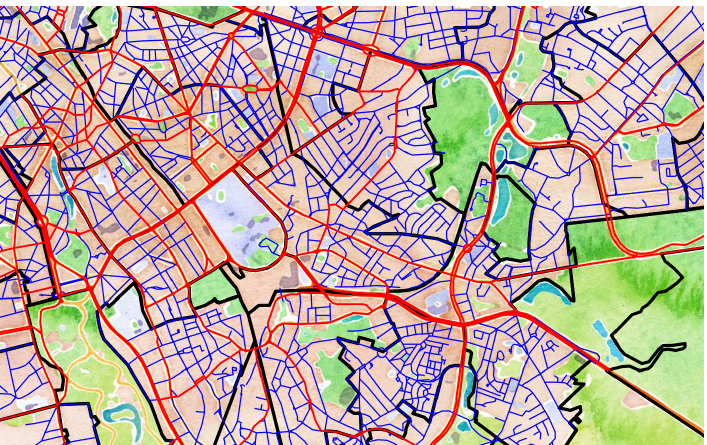
Figure 5. Zoom on highways extracted from OSM for Brussels. The blue lines are residential streets, whereas the red ones are major city highways. The bold black lines represent the neighbor- hoods’